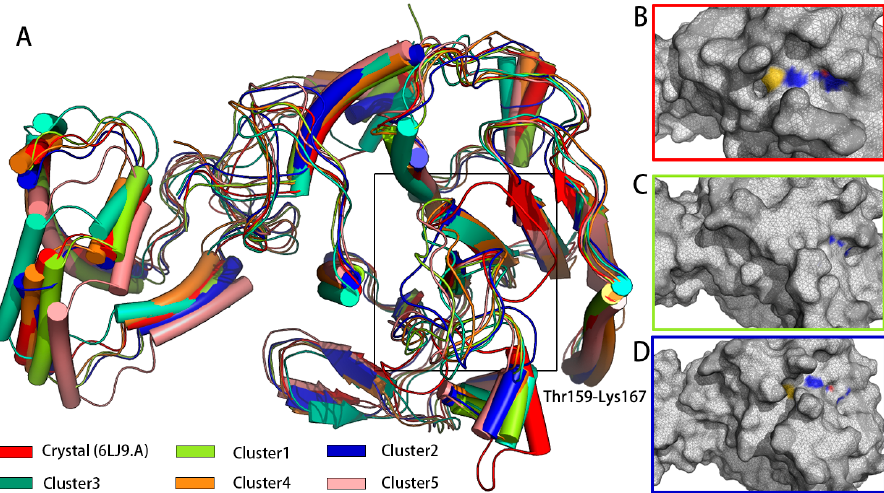
Figure 1. pS273R Molecular dynamics simulation. ( A ) Molecular kinetics of RMSD values for long ‐ scaffolded carbon atoms of pS273R over 200 ns. ( B ) Molecular kinetics of RMSF values for amino acids of pS273R over 200 ns. ( C ) RMSF at 200 ns projected onto the pS273R structure. ( D ) Molecular dynamics simulation trajectory of pS273R from 0 to 200 ns . Note: Black box means the loop region of Thr159 ‐ Lys167 of pS273R.